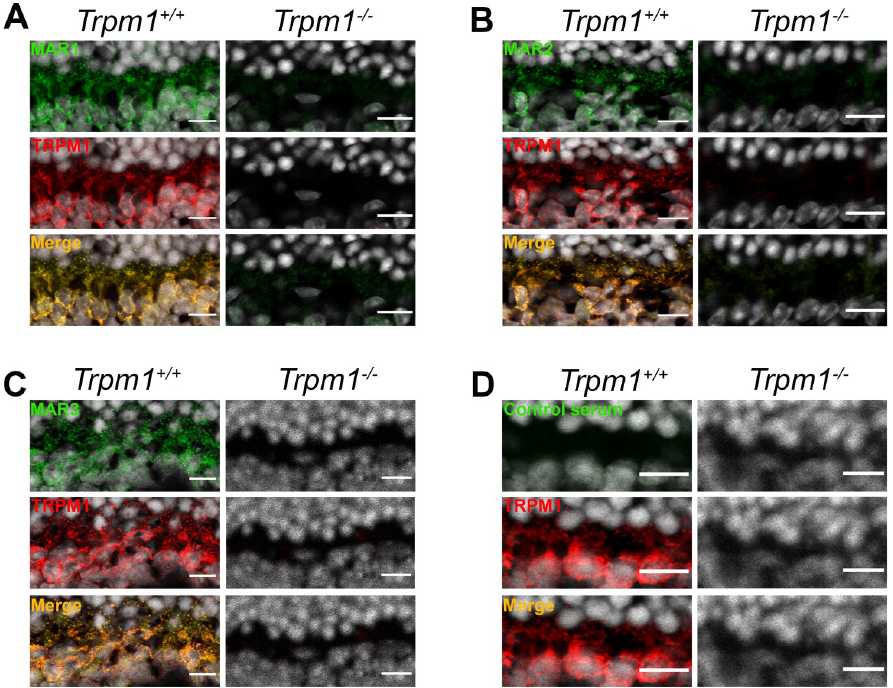
Fig 4. Immunolocalization on Trpm1 +/+ and Trpm1 -/- mouse retinal cryosections. (A) TRPM1 (red) staining colocalized (yellow, merge) with MAR1 (green) in Trpm1 +/+ and both staining were absent in Trpm1 -/- mouse. (B) TRPM1 (red) staining colocalized (yellow, merge) with MAR2 (green) in Trpm1 +/+ and both staining were absent in Trpm1 -/- mouse. (C) TRPM1 (red) staining colocalized (yellow, merge) with MAR3 (green) in Trpm1 +/+ and both staining were absent in Trpm1 -/- mouse. (D) TRPM1 (red) staining was present in Trpm1 +/+ and absent in Trpm1 -/ - mice. Control serum did not reveal any staining. Scale bars: 10 μ